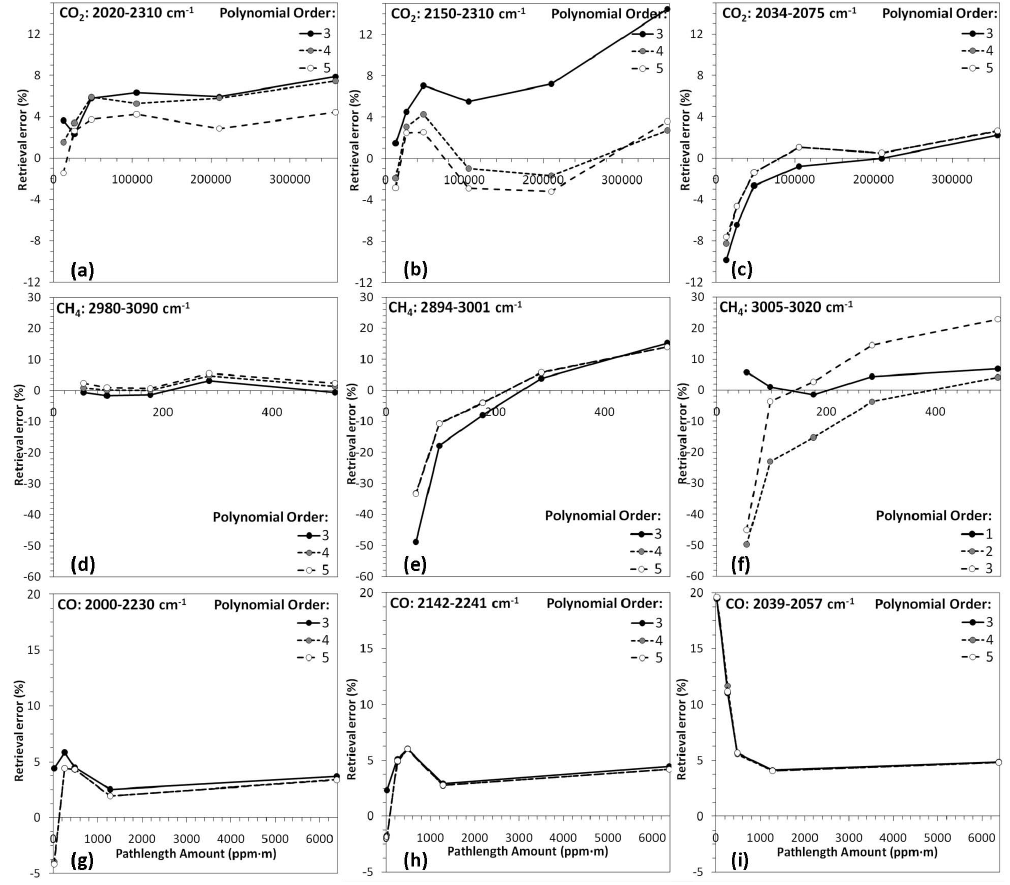
Fig. 7. Retrieval errors for CO 2 , CH 4 and CO trace gas retrievals resulting from use of the MALT model and NLLS fitting procedure with OP-FTIR spectra from a gas cell containing samples of these three gases over wide concentration ranges. Retrievals were made using three different spectral windows for each trace gas and three different polynomial orders. In order to aid comparison of the error magnitudes for the retrievals of each trace gas, the same y-axis range is used to display the results from the three spectral windows tested. Retrieval error magnitude is seen to vary quite widely between the different spectral windows used to retrieve the pathlength amount of a particular trace gas, and for some windows between the different polynomial orders